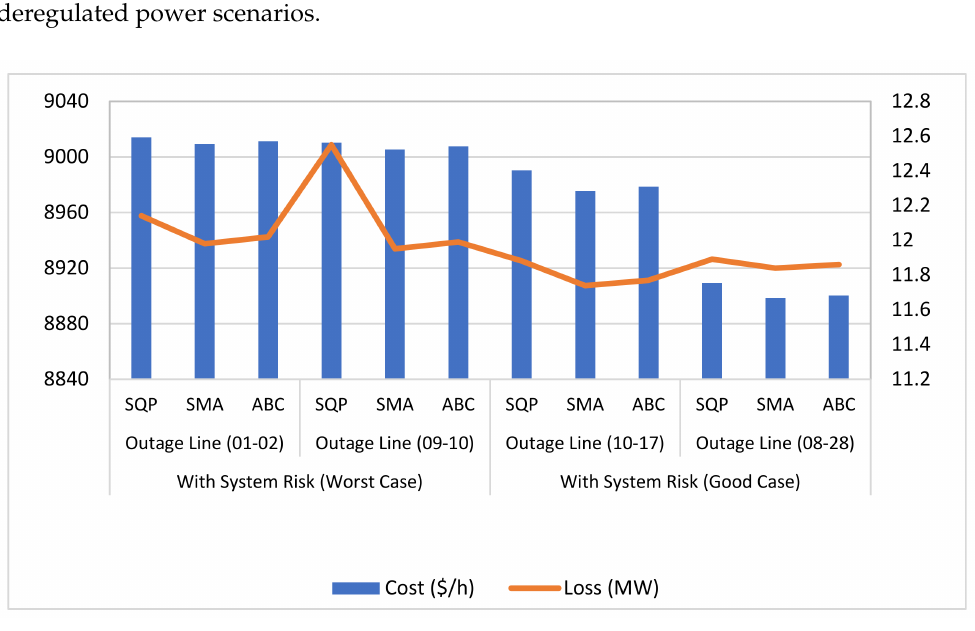
Figure 5. Optimal cost and loss values considering system risk for IEEE 30-bus